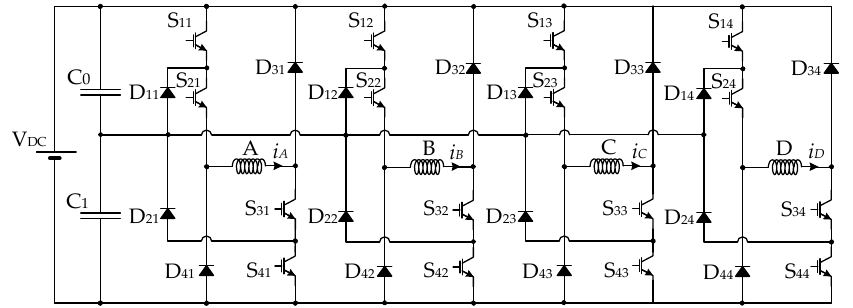
Figure 1. Neutral Point Clamped Asymmetric Half-Bridge ( NPC-AHB ) applied to a 8/6 SRM .